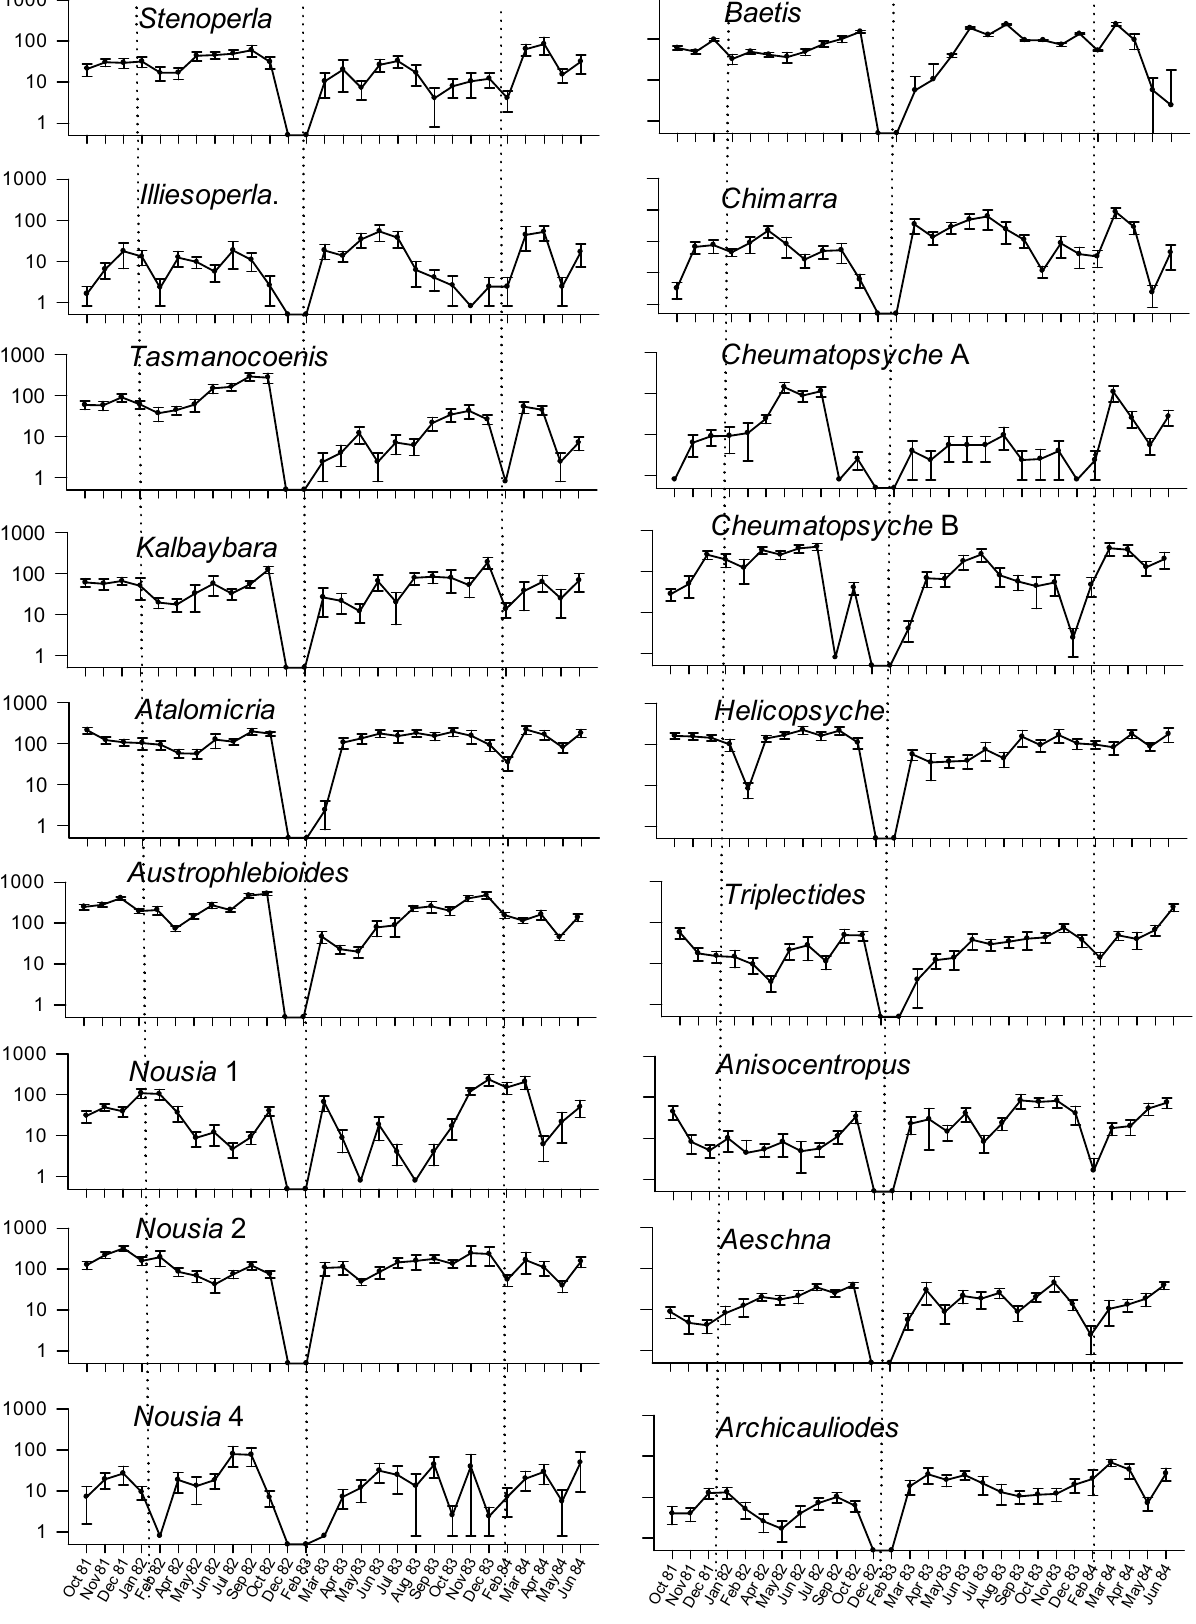
Figure 2. Monthly changes in abundance (± s.e.) of the most numerous invertebrate taxa in Yuccabine Creek, October 1981–June 1984. Dotted vertical lines indicate January of each